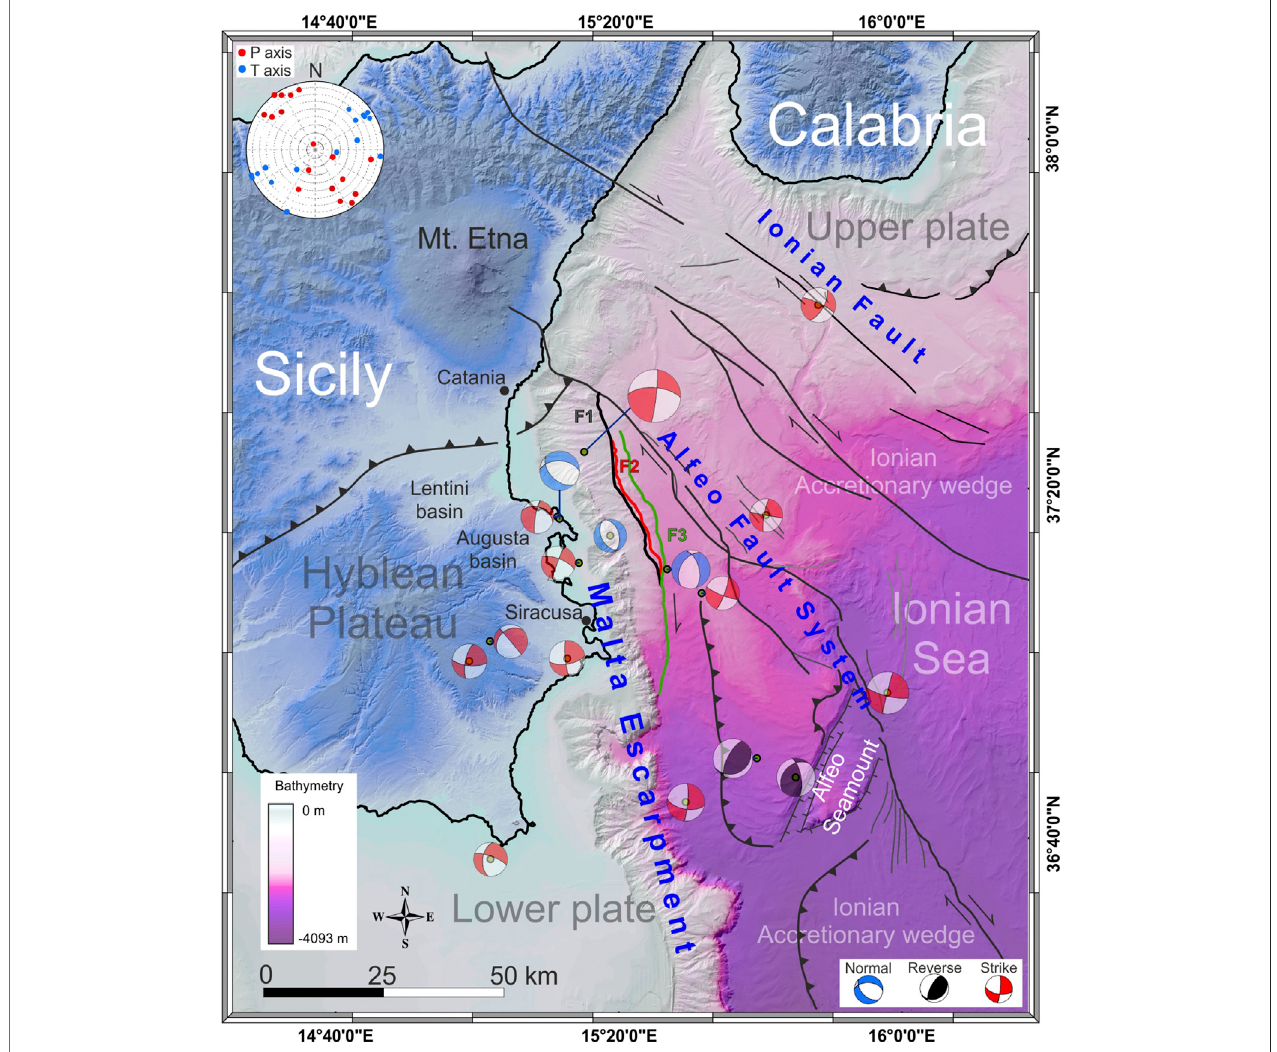
FIGURE 9 | Mapped faults (F1, F2, and F3) framed in the larger tectonic framework of the Western Ionian Basin. Alfeo Fault system and Ionian Fault are from Gutscher et al. (2016) and Polonia et al. (2016). Available focal solutions of M > 3.5 earthquakes (Pondrelli, 2002; Scarfì et al., 2013; Musumeci et al., 2014; Scarfì et al., 2016) and PT axes computation (see diagram in the top-left) support transtensional deformation in the studied area.